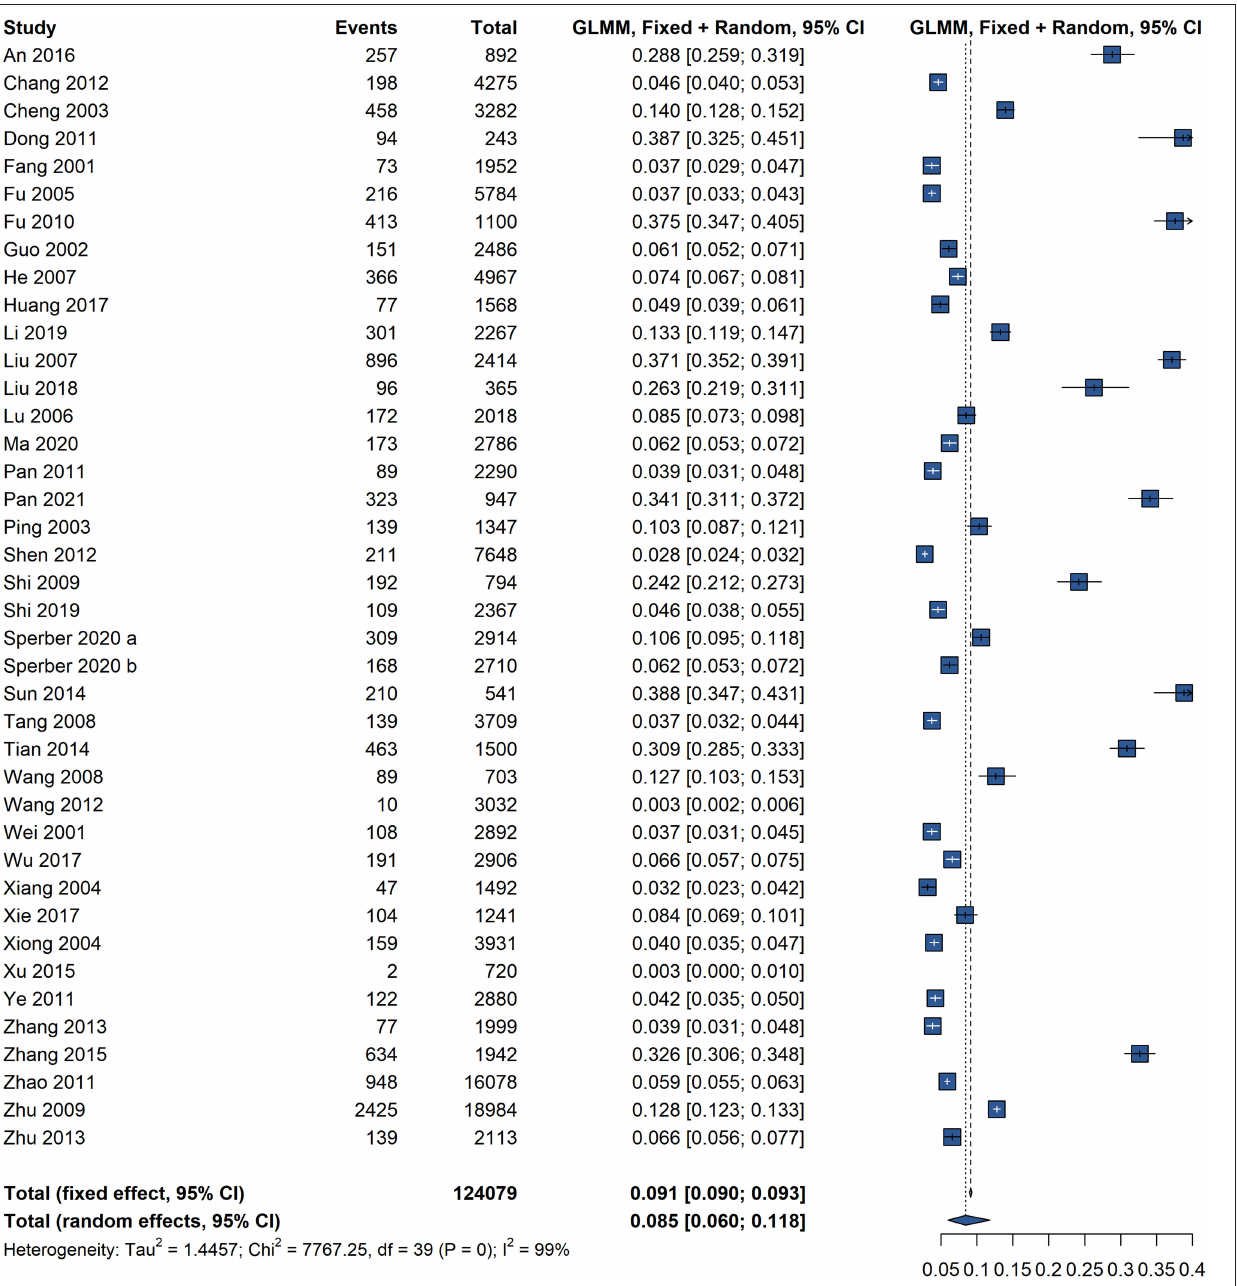
FIGURE 2 | Forest plot of prevalence of functional constipation according to the Rome